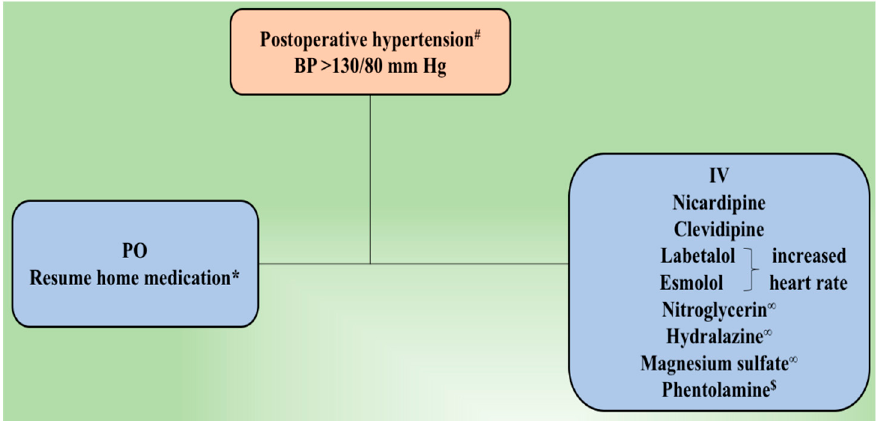
Figure 1. Postoperative management of hypertension following tumor resection. # Residual or metastatic disease causing an increased blood pressure is treated using α –adrenoceptor blocker. If necessary, β -adrenoceptor blocker and/or calcium channel blocker is added. β -adrenoceptor blocker might be used at first for epinephrine-secreting tumors. ∞ Management of hypertensive emergency. * Underlying essential hypertension is treated according to currently accepted guidelines.